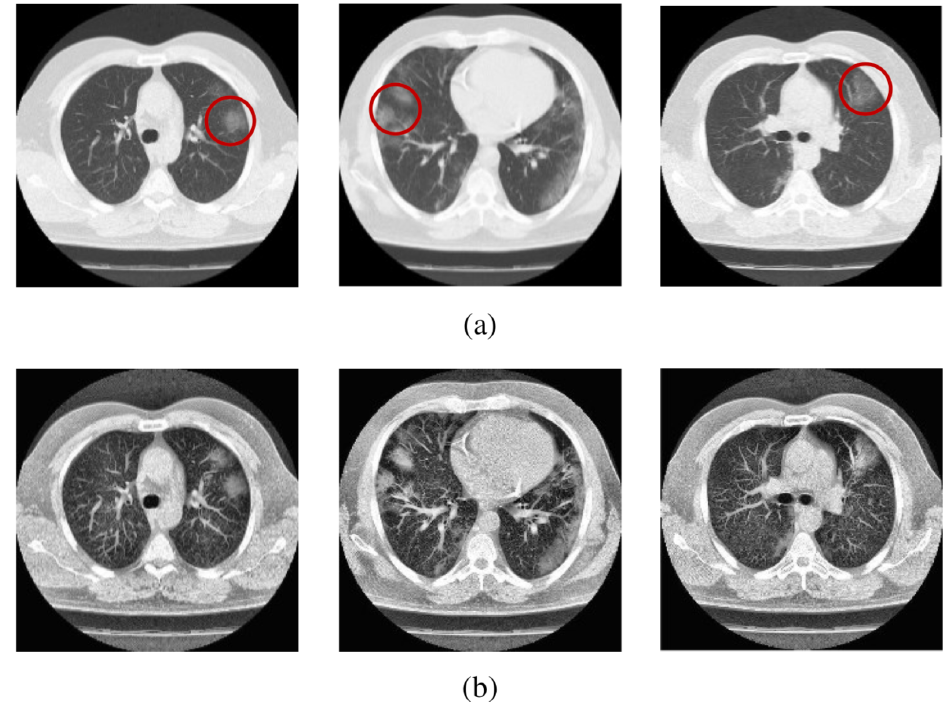
Figure 27. Sample scans from the dataset before and after enhancement showing infected lungs. ( a ) Original Computer Tomography scans, with red circles highlighting some regions where fibrosis can be seen; ( b ) enhanced Computer Tomography scans using q = 0.5. From